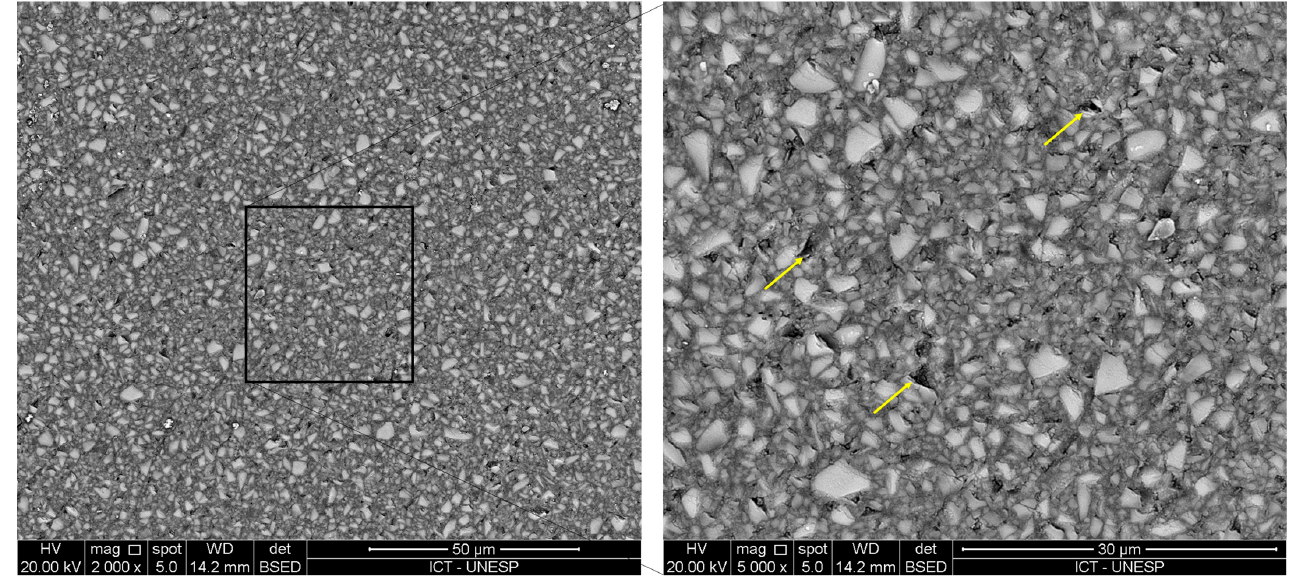
Figure 3. Representative Scanning Electron Microscopy (Admira Fusion) after polishing procedure at different magnifications (2000 and 5000×). The yellow arrows indicate the regions of surface defects caused by filler particles removal.